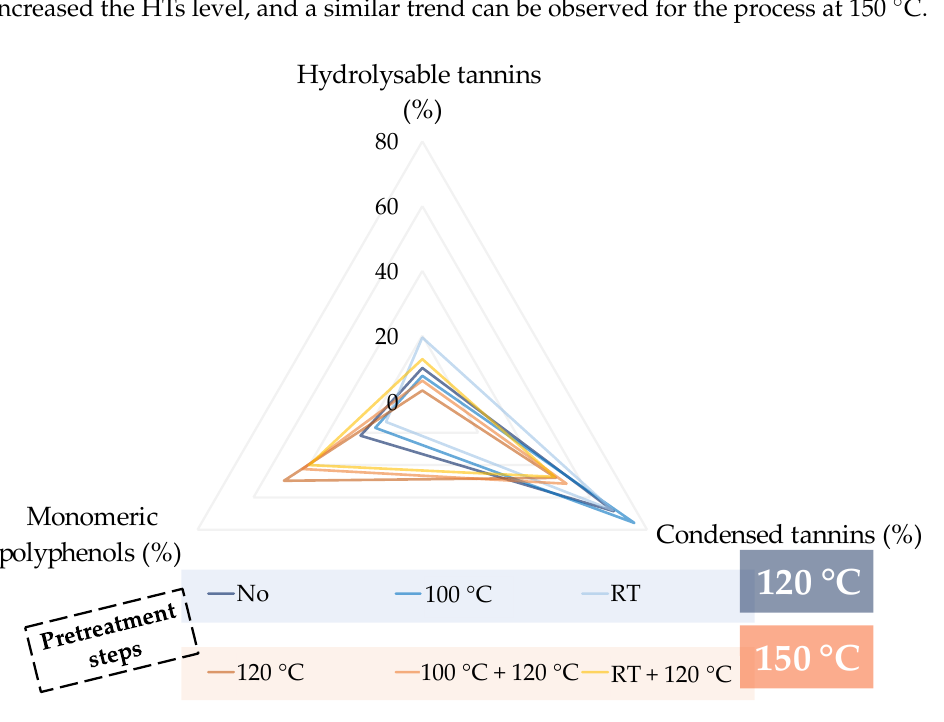
Figure 5. Pre-treatment influence on extract population of tannins and polyphenols.